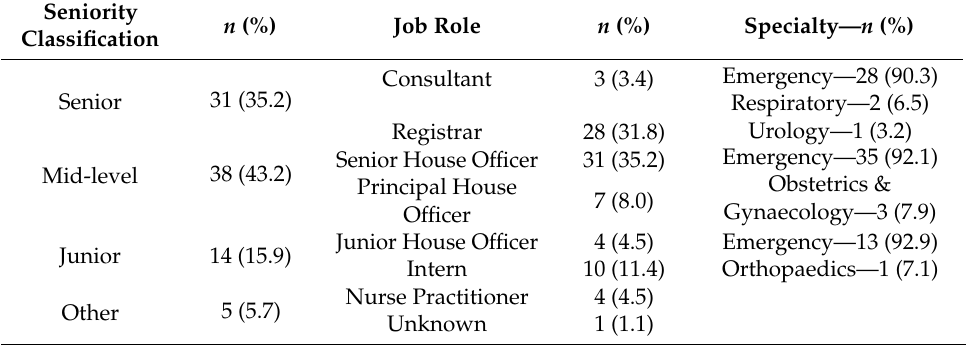
Table 2. Characteristics of Respondents.